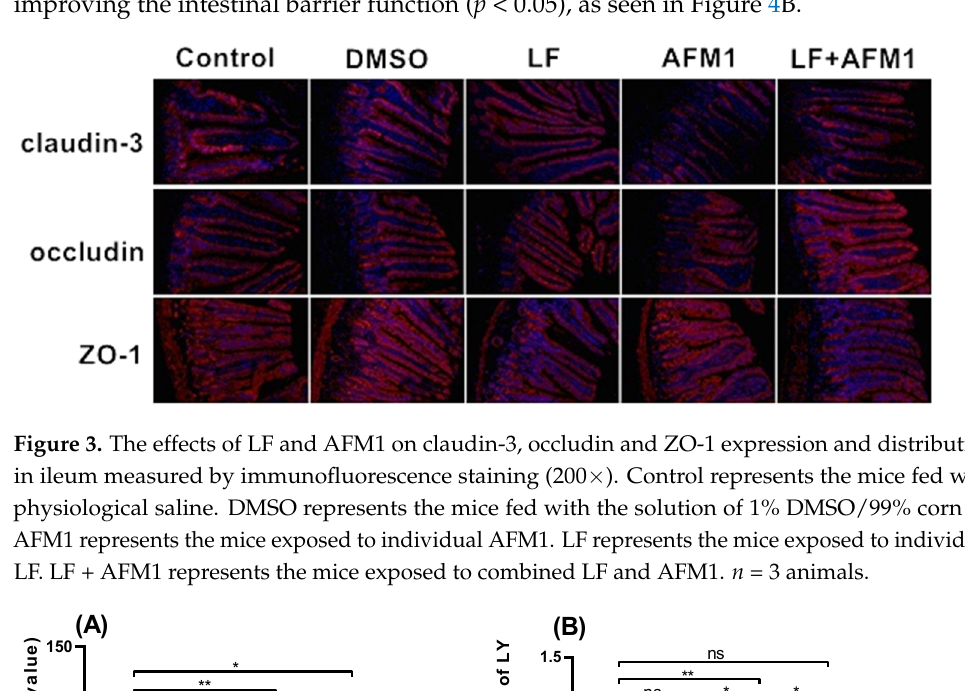
depth. Values represent the means ± SEM ( n = three animals). * represents p < 0.05, ** represents p < 0.01, *** represents p < 0.001.